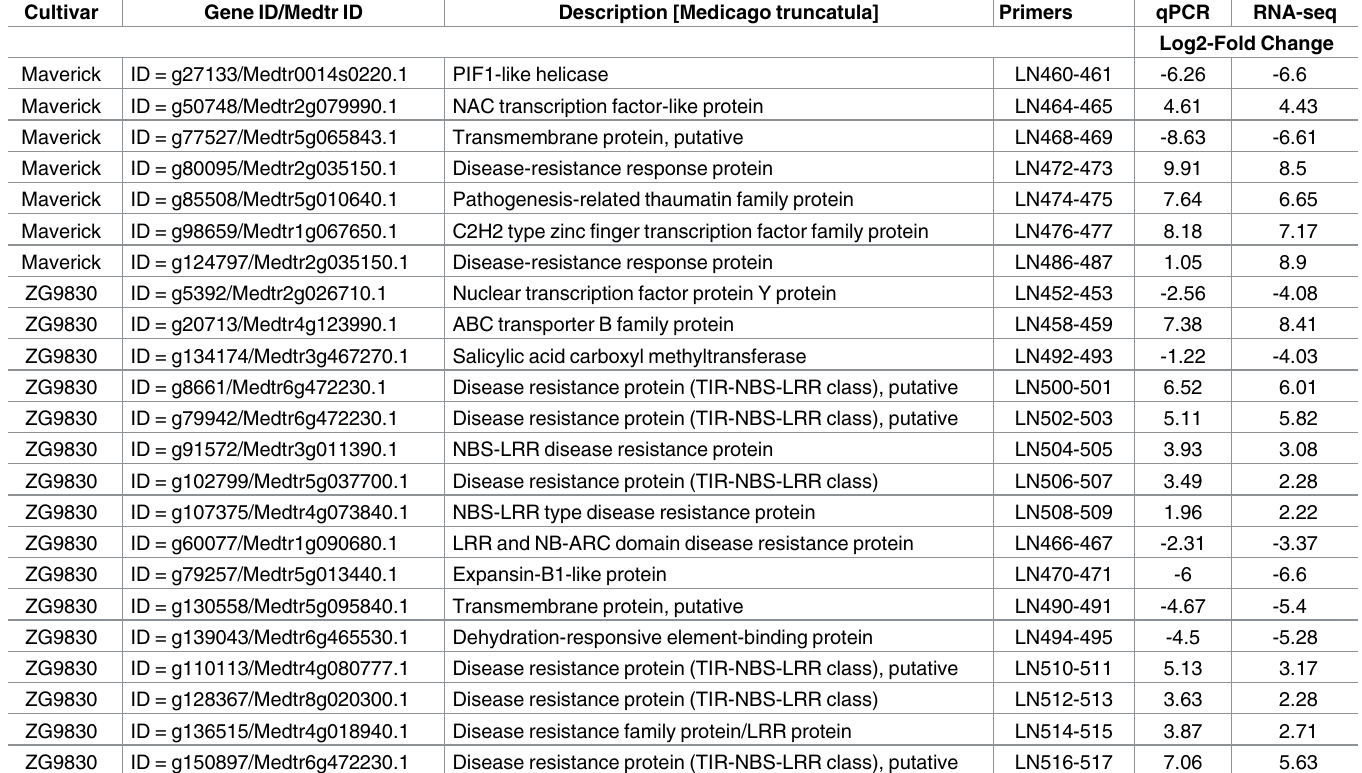
Table 3. Confirmation of the transcriptomic data by quantitative real-time